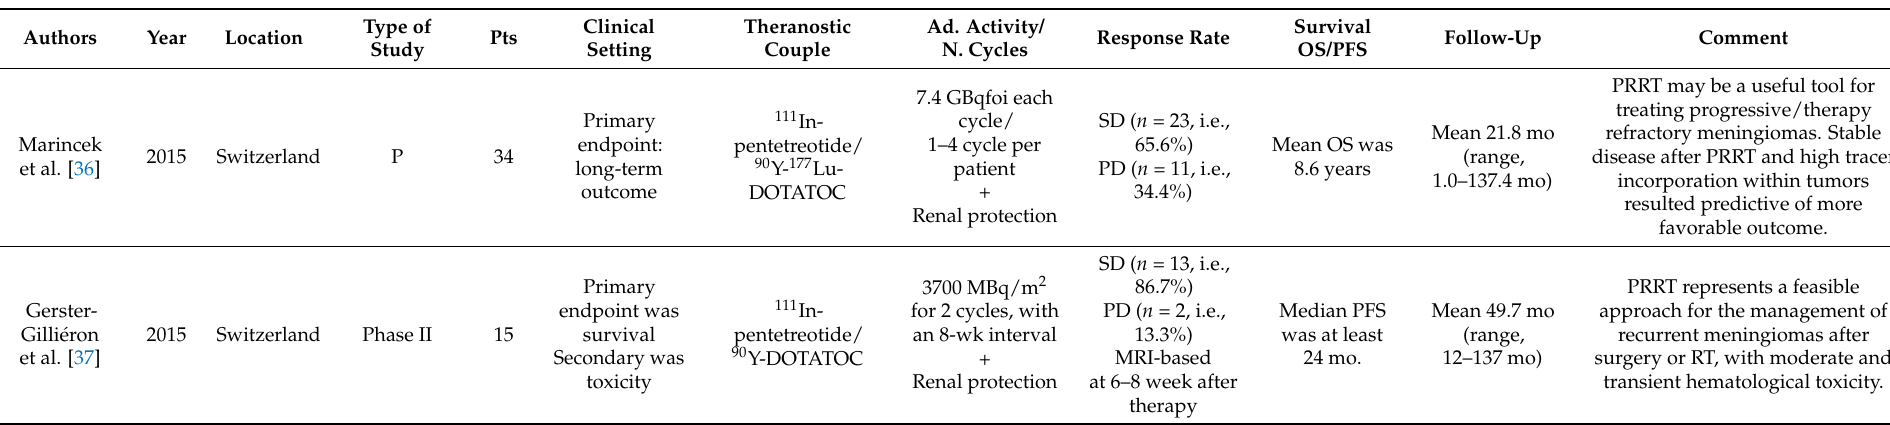
Table 2. Main characteristics of selected papers on PRRT applications in